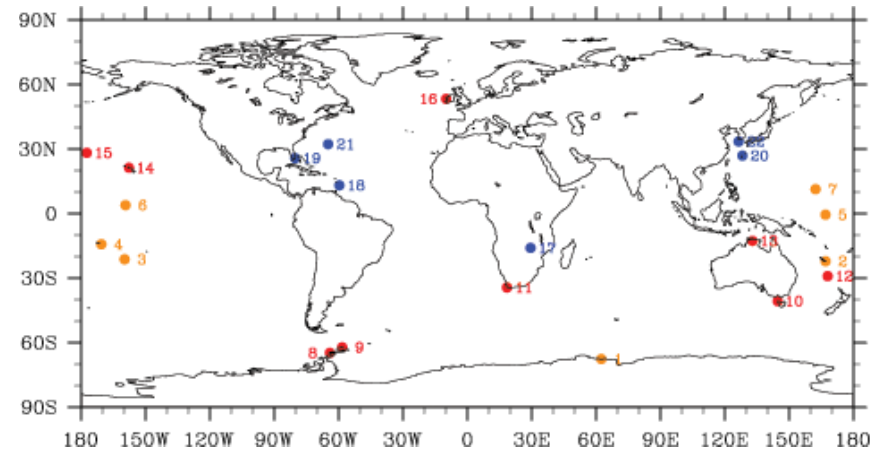
Fig. 8. Location of sites from the extended University of Miami dataset for annual and monthly mean dust surface concentration measure- ments. Sites are divided into three groups according to the magnitude of the data and distances from the dust sources: remote sites with low dust surface concentration (orange), sites under the influence of dust sources and with medium concentrations (red), and sites downwind the major dust sources in Africa and Asia and with high concentrations (blue). Name, latitude and longitude of each site are listed in Table 6. Table 6. Sites from the extended University of Miami dataset for climatological dust surface concentration measurements. Sites are divided into three groups according to the magnitude of data and distances from the dust sources. N is the number of each site as shown in Fig. 8. The asterisks mark the sites in addition to the University of Miami dataset.